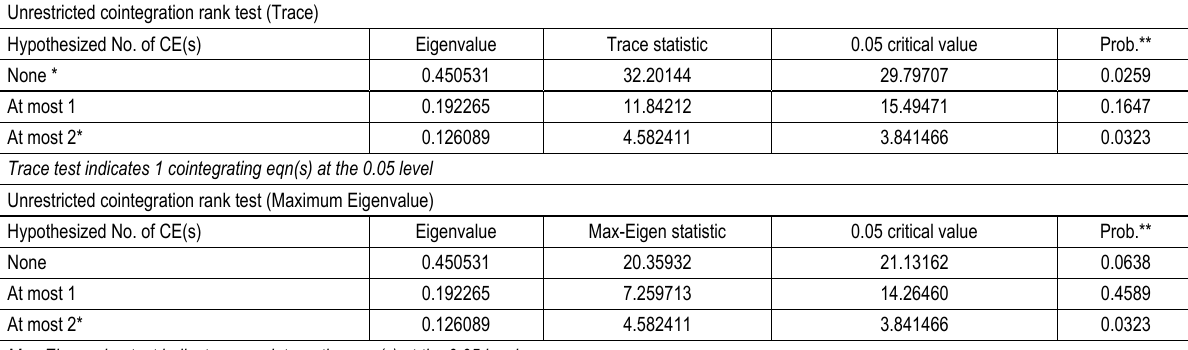
Table 6. Trace and maximum Eigenvalue test